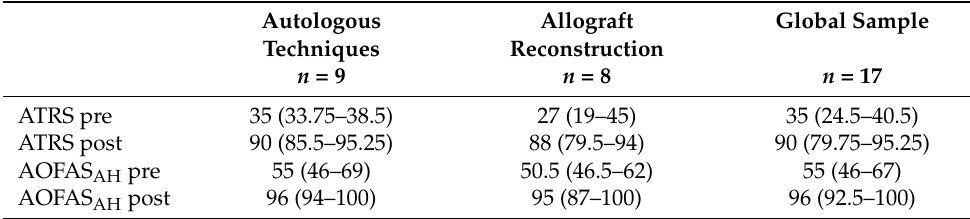
Table 3. Preoperative and postoperative ATRS and AOFAS AH scores in the global and the different subgroups at the end of the follow-up, a mean of 82 ± 36.61 months (range 26–150). Results presented as median (interquartile range). Autologous Allograft Global Sample Techniques